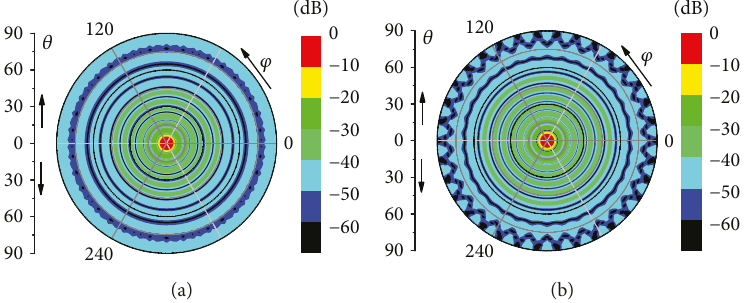
Figure 8: Power patterns of SUACRA 3 and 4: (a) SUACRA 3 and (b) SUACRA 4. sin( 휃 ) = 0.107 0 Edge of the receiving region